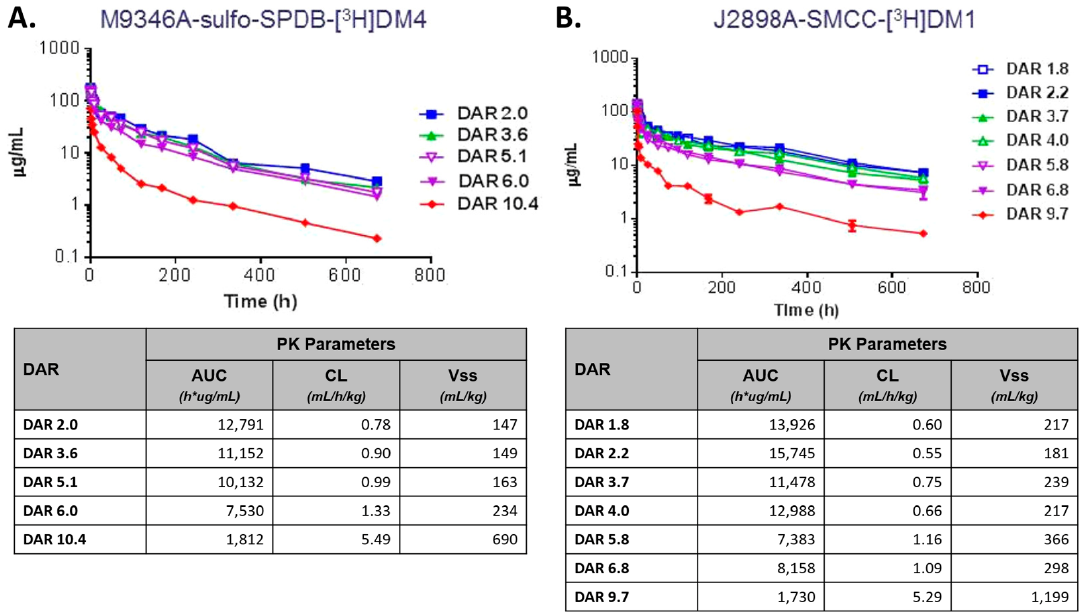
Figure 4. Pharmacokinetic studies evaluating antibody–drug conjugate (ADC) concentrations using radiolabeled ADCs. Clearance of M9346A–sulfo-SPDB–[3H]DM4 ( A ) and J2898A–SMCC–[3H]DM1